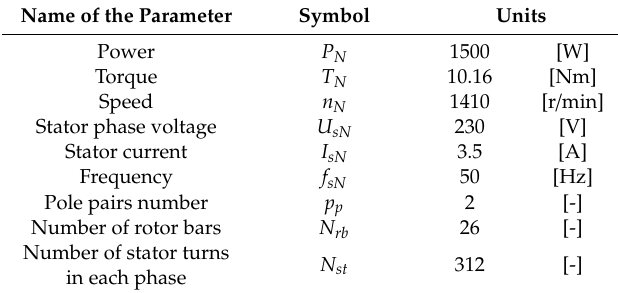
Table 1. Rated parameters of the tested induction motor.